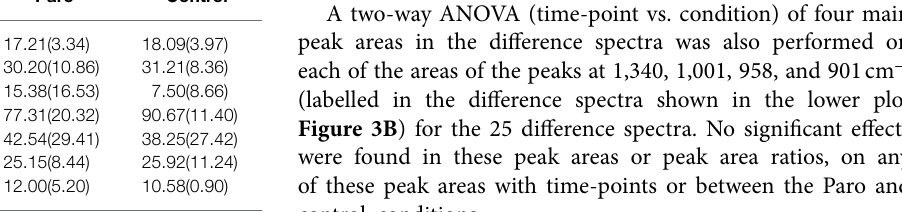
TABLE 3 | Summary statistics for the outcomes at the post-intervention time- point across condition. Condition Paro